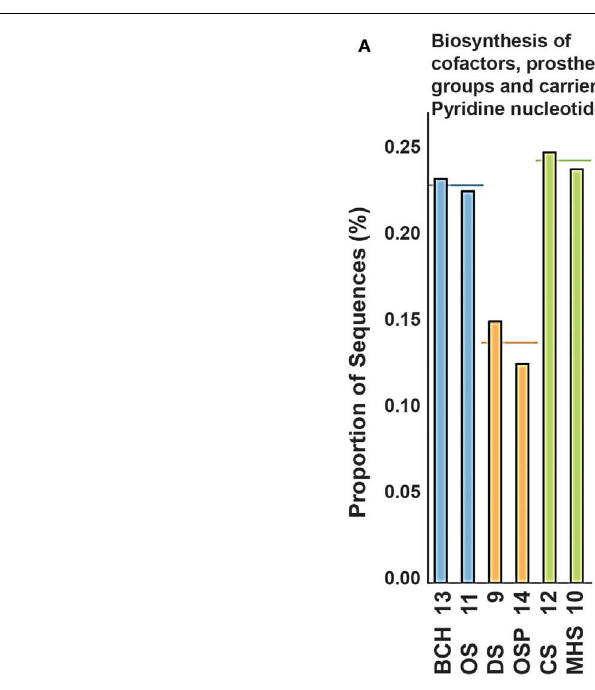
FIGUREA7 | Functional categories with the most significant differences in relative gene abundance among the sixAquificales streamer communities [(A) biosynthesis of cofactors, prosthetic groups and carriers and (B) signal transduction: PTS; p -values = 0.0047 and 0.0057,